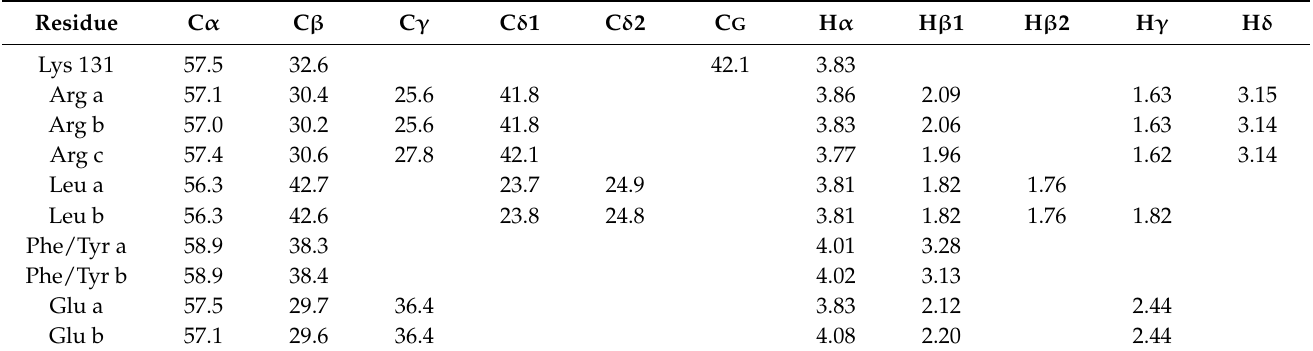
Table 1. Amino acid types identified in hCCH-TOCSY experiment of KcsA in 9:1 DOPE-DOPS at pH 7.2.